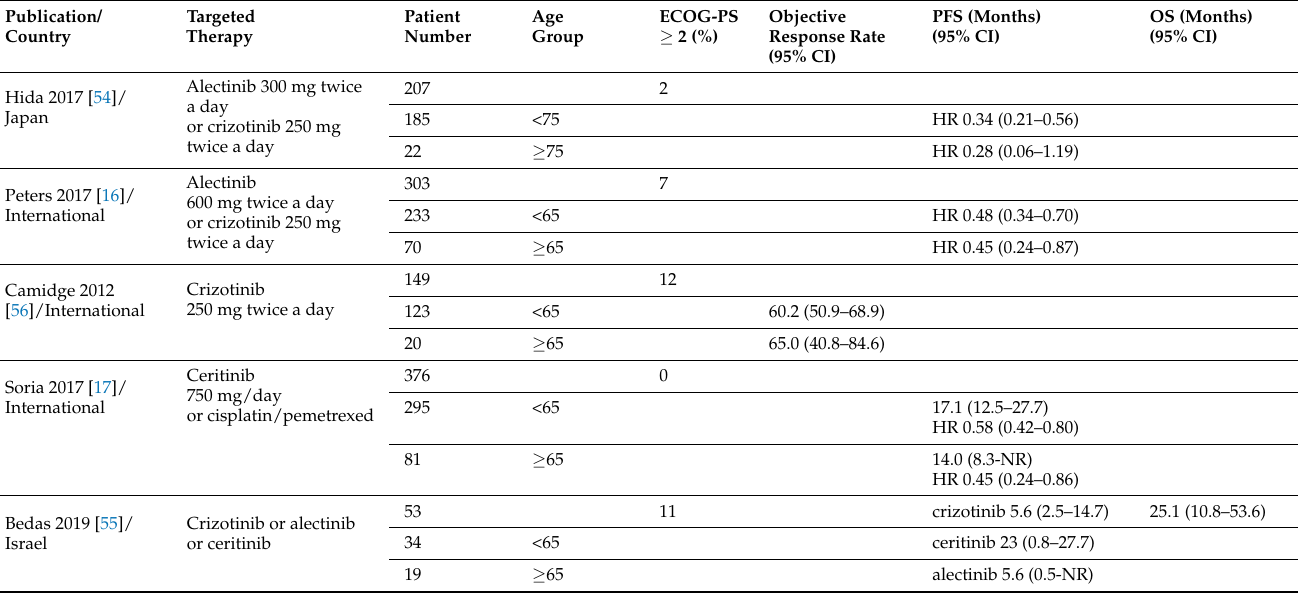
Table 3. Targeted therapy efficacy results in older patients in randomized or non-randomized trials (subgroup post-hoc